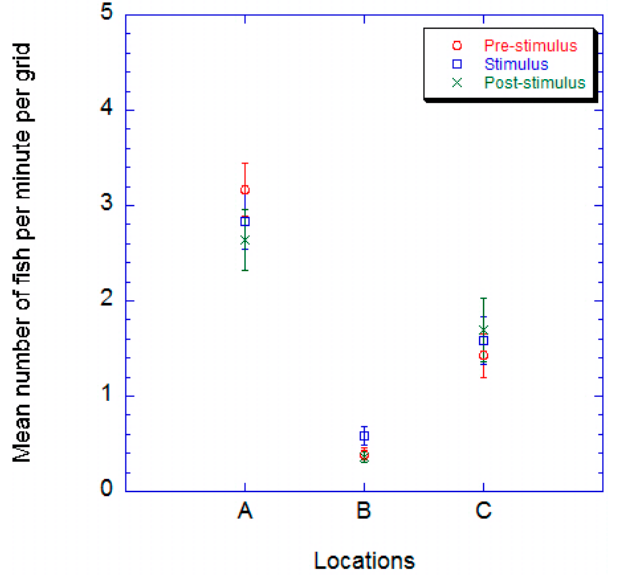
Figure 2. Mean (±SE) number of juvenile channel catfish per minute per grid (N = 13). Figure 2. Mean ( ± SE) number of juvenile channel catfish per minute per grid (N =